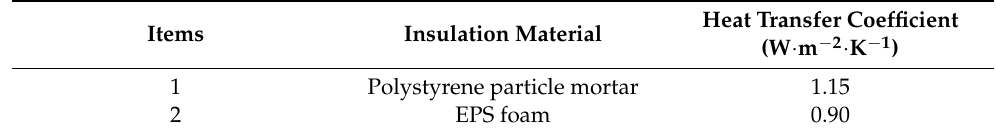
Table 1. Two different test results of the exterior wall panel.